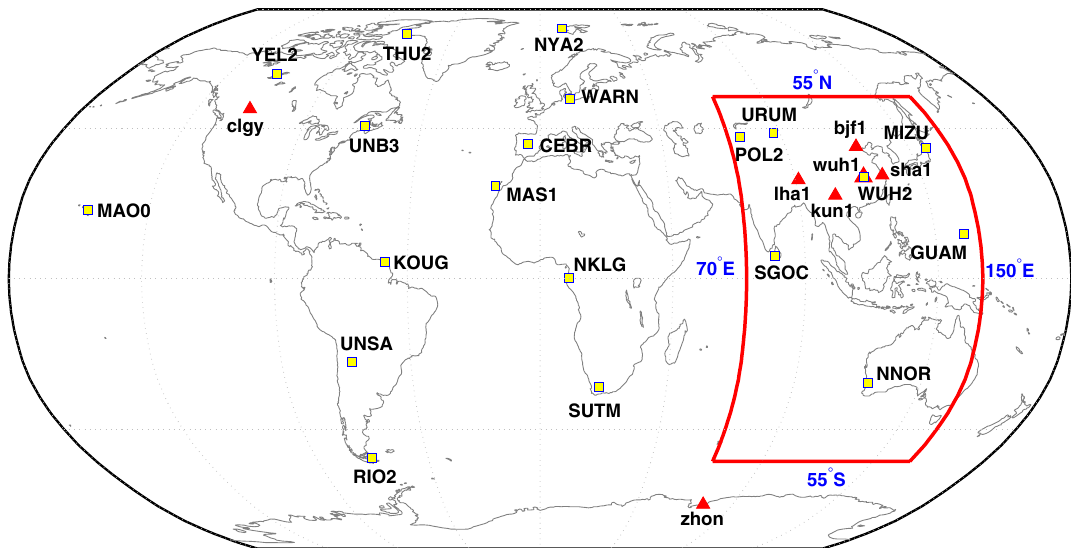
Figure 7. Distribution map of the observation stations. A red box is drawn to highlight the key BDS service area (55° S–55° N, 70° E–150° E). The MGEX station names are in the capital letters and the iGMAS station names are in the lowercase letters, which are also respectively labeled as ‘yellow square’ and ‘red